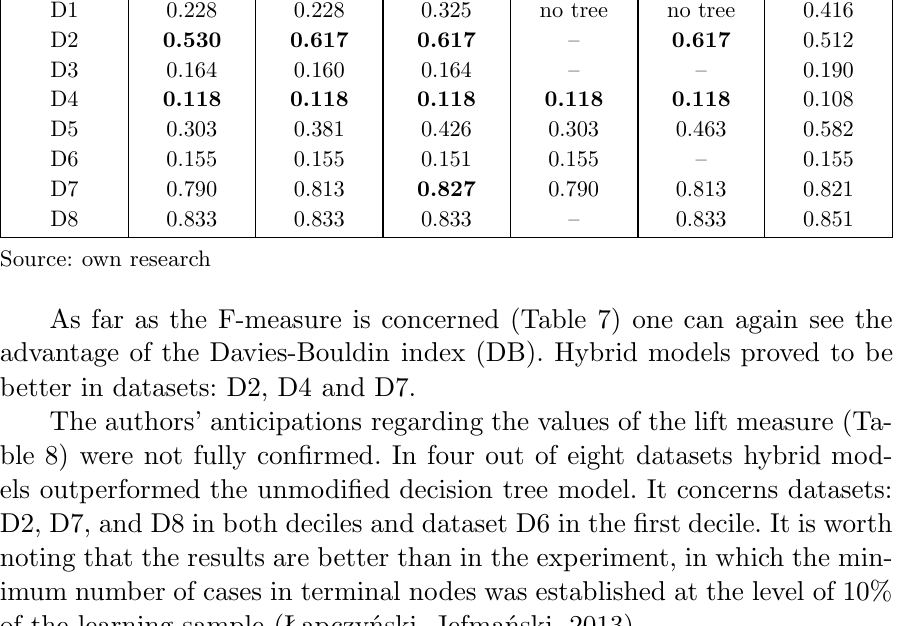
Dataset Hybrid CH Hybrid KL Hybrid DB